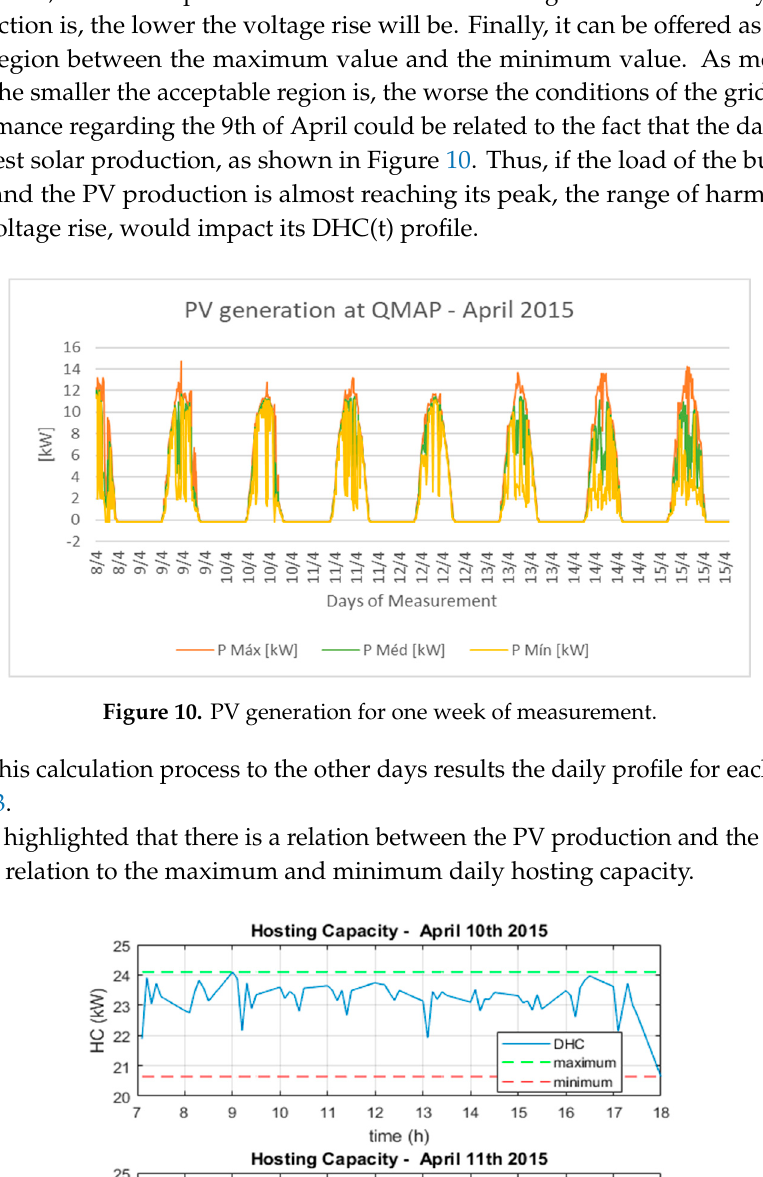
Figure 11. The daily DHC(t) for the in relation to April 10th and 11th, 2015.